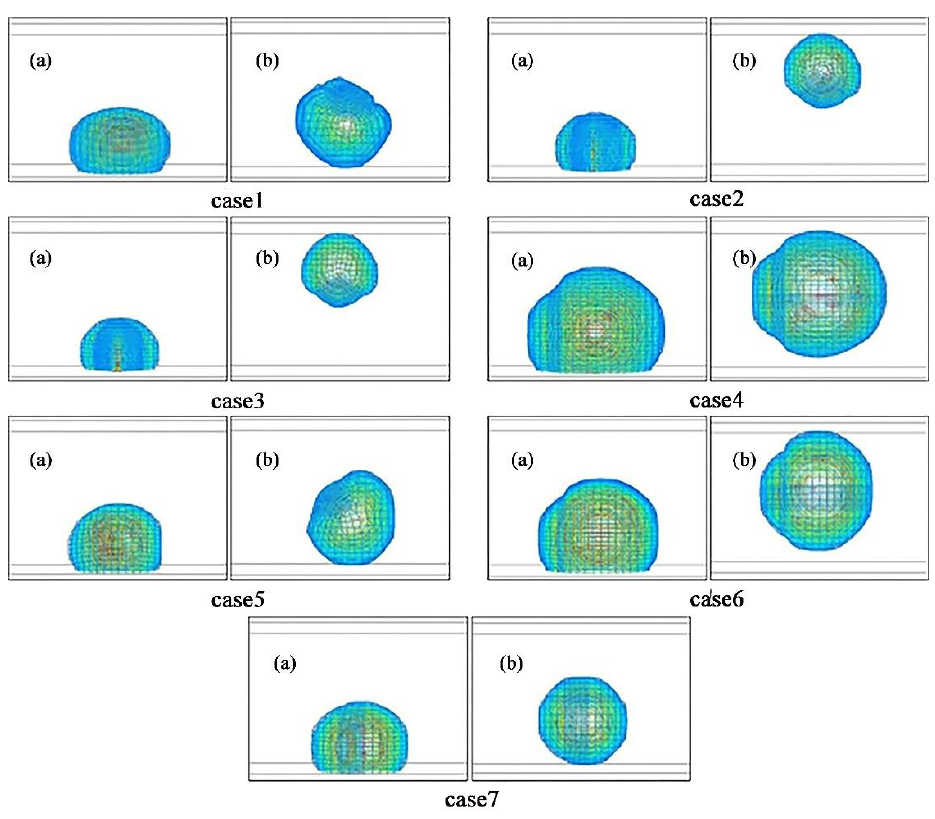
Figure 3. Morphology of critical droplets under different cases (( a ) front view, ( b ) top view; the airflow direction is from left to right).